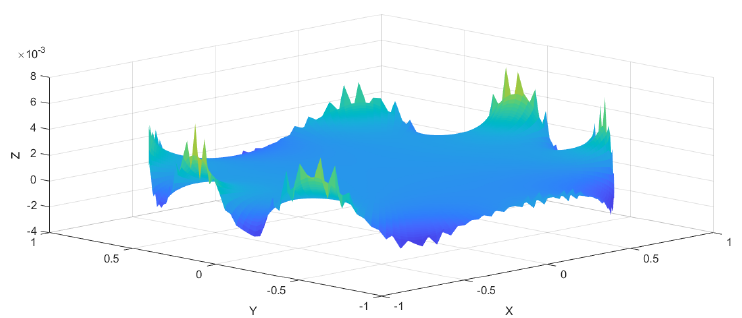
Figure 2. Pointwise error of the numerical solution ˜ u h of (21) for α = 0.75 and N = 512 inside the boundary. One can observe that most of the error accumulates close to the boundary.